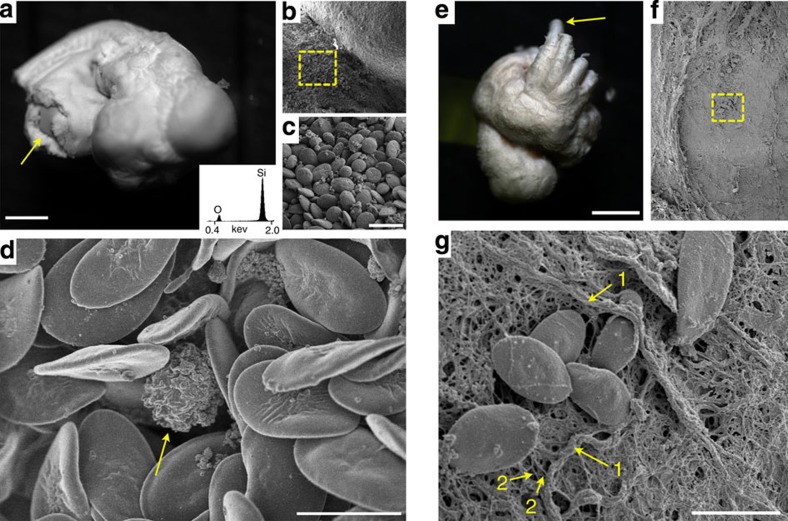
Structural preservation of deep tissue in silica replicas of chicken embryos.(a) Silica replica of a 4-day-old chicken embryo fractured post silicification and subsequently calcined (scale bar, 1 mm). The inset shows an energy-dispersive X-ray spectrum (EDS) of the silica replica. Arrow in a shows the exposed internal tissue magnified via SEM in b and further magnified in c, scale bar, 20 μm. (d) Silica replica of a white blood cell (arrow) nestled among SBR red blood cells within a blood vessel in chicken embryo liver (scale bar, 10 μm). (e) Silica replica of heart from a 17-day-old chicken embryo (scale bar, 2 mm). (f) SEM of the surface of a blood vessel (denoted by arrow in panel e) and further magnified in g showing red blood cell replicas bound to presumable elastin and collagenous fibres with diameters spanning microns (1) to 10s of nanometres (2, indicates ~60–80 nm fibres). SEM images were acquired following sputter coating of Au/Pd to a thickness of 10 nm.